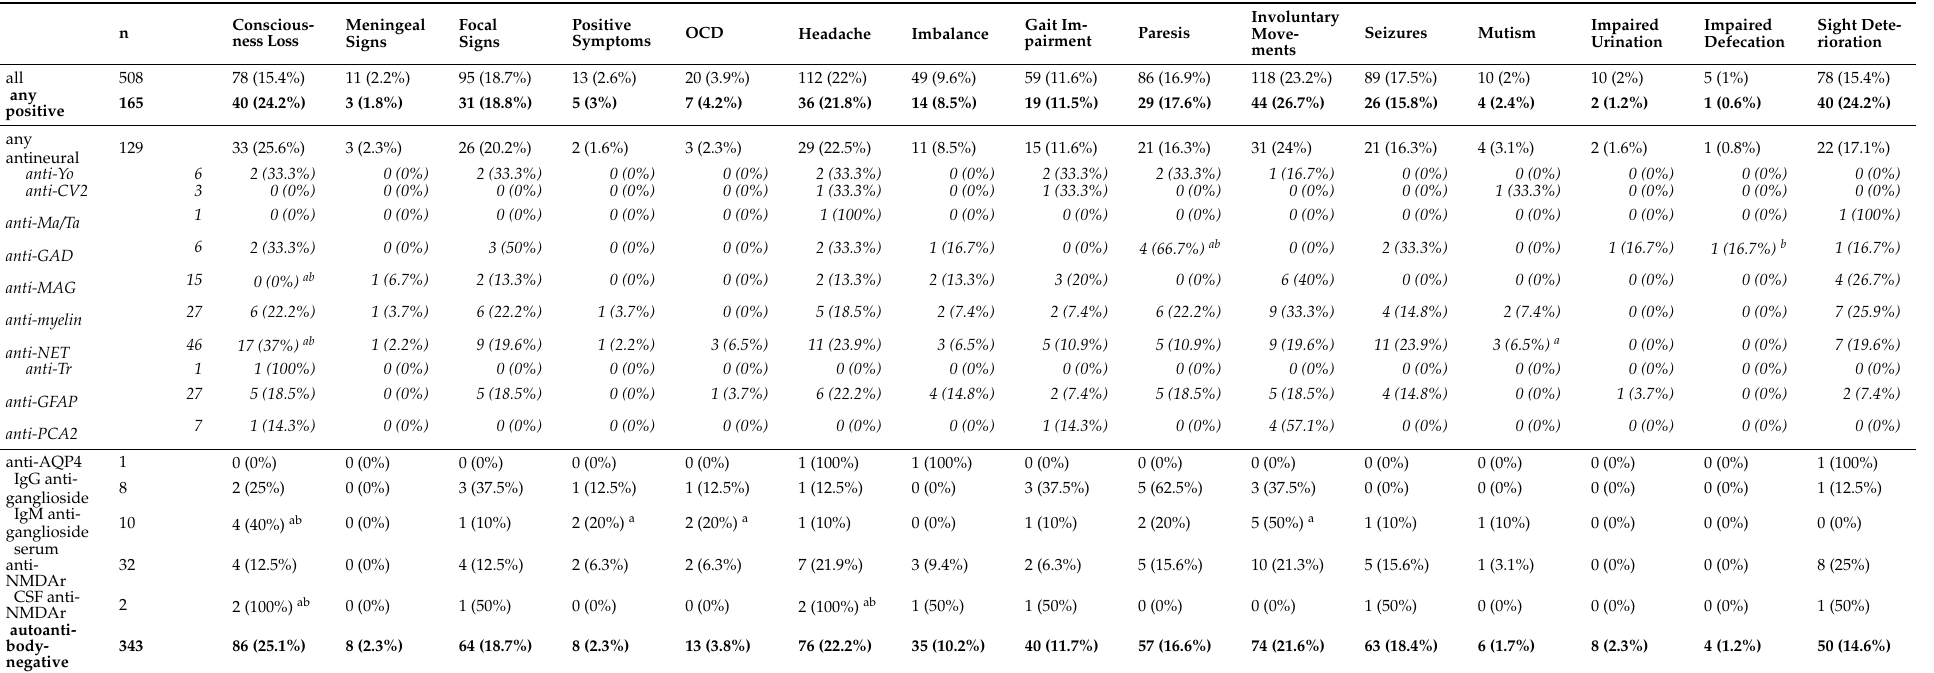
Table 3. The incidence of analysed symptoms with the division based on detected